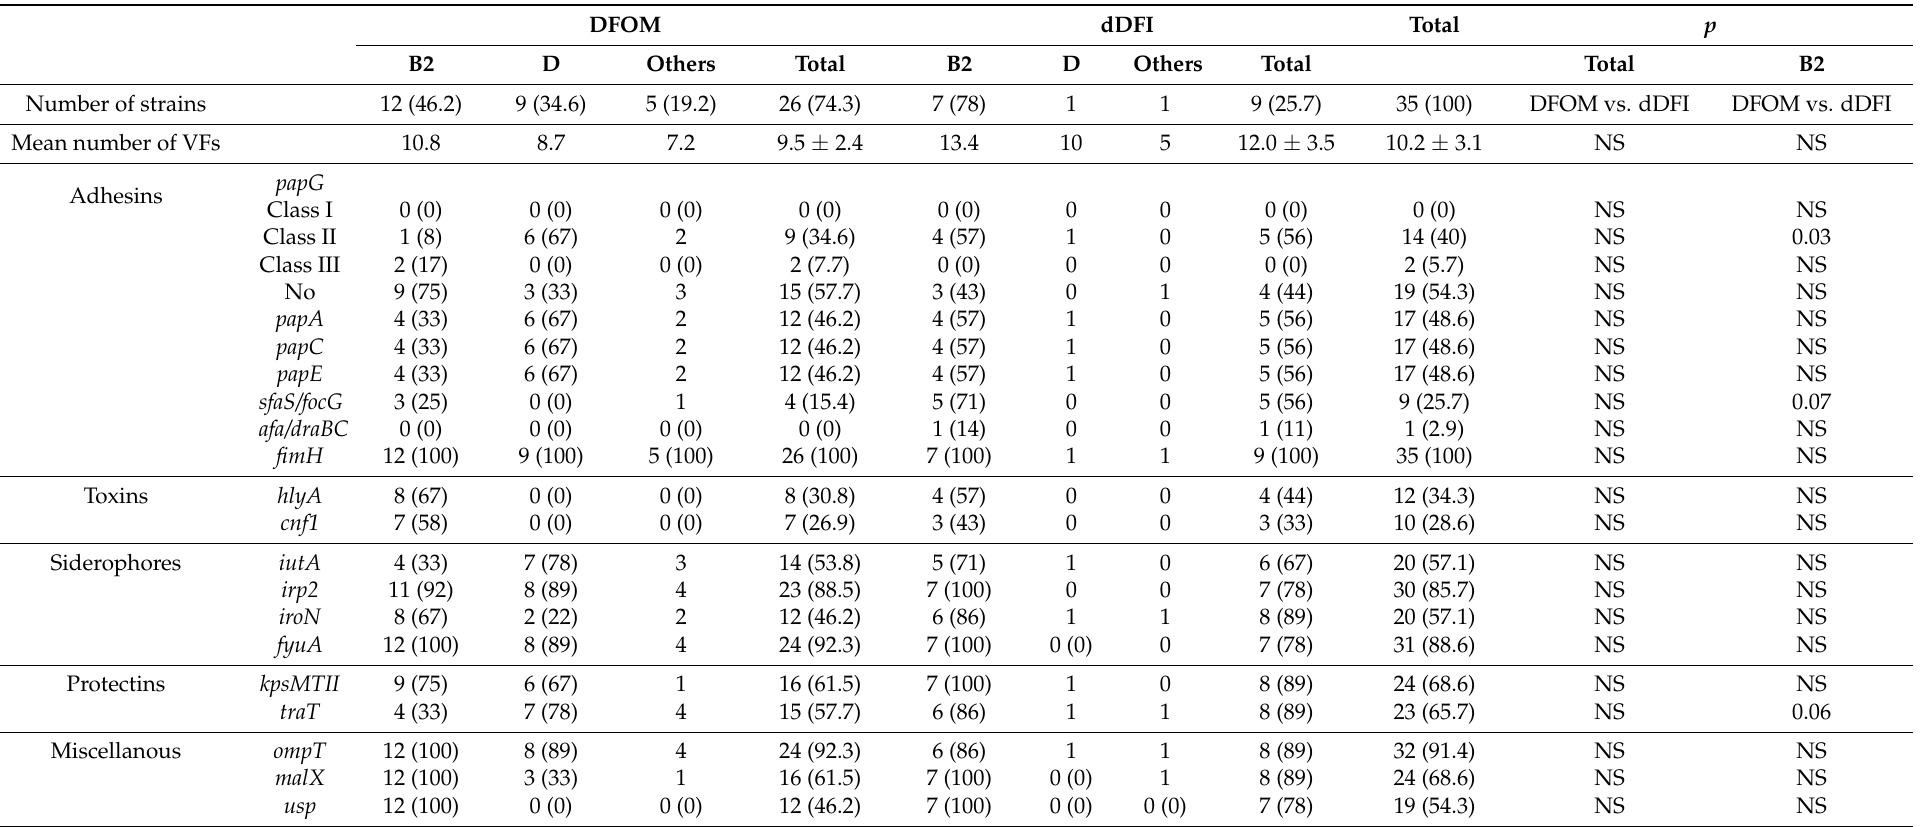
Table 3. Distribution of virulence factors in the E. coli isolated from diabetic foot osteomyelitis (DFOM) and deep diabetic foot infection